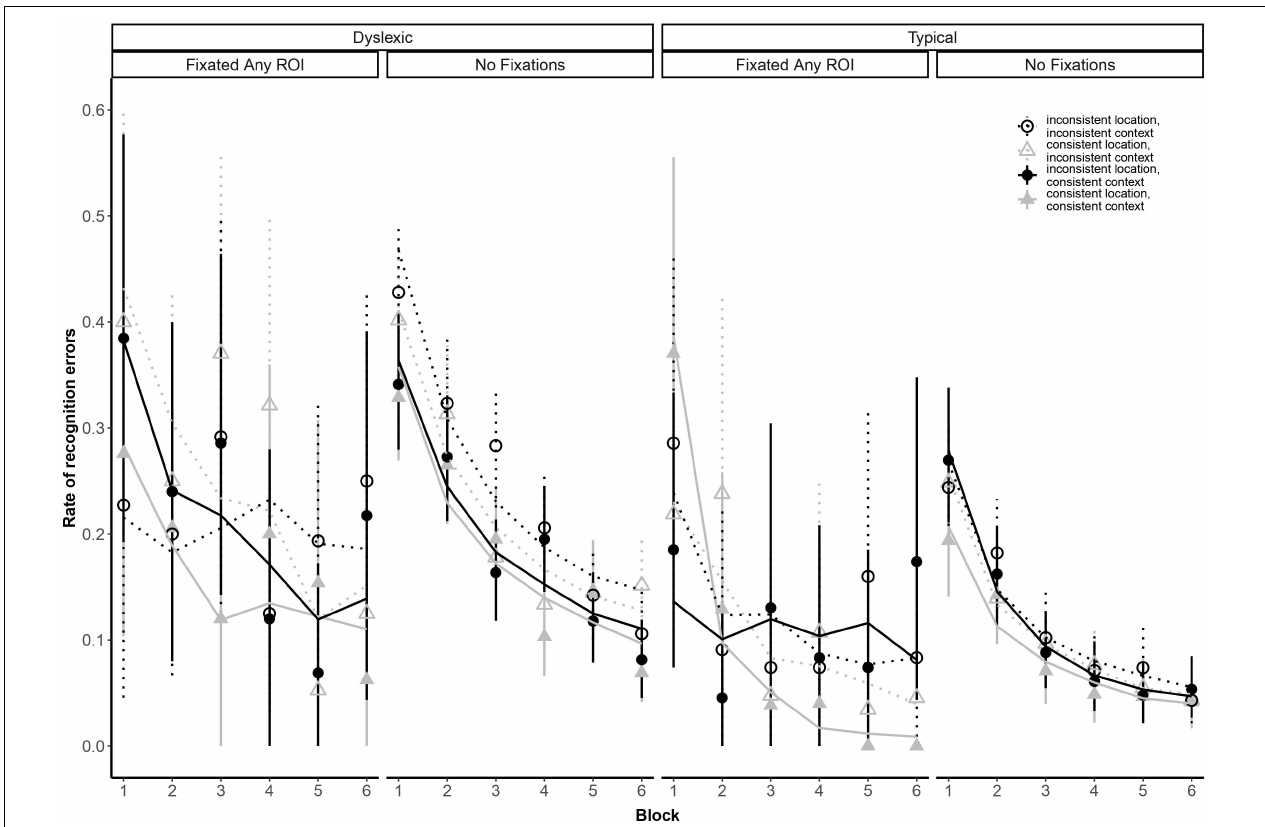
FIGURE 4 | Subject-weighted mean recognition error rate as a function of repetition (i.e., blocks), group membership, context and location consistency, and whether participants looked at one of the three regions of interest (ROI). Point ranges represent bootstrapped confidence intervals, and lines represent logistic regression model